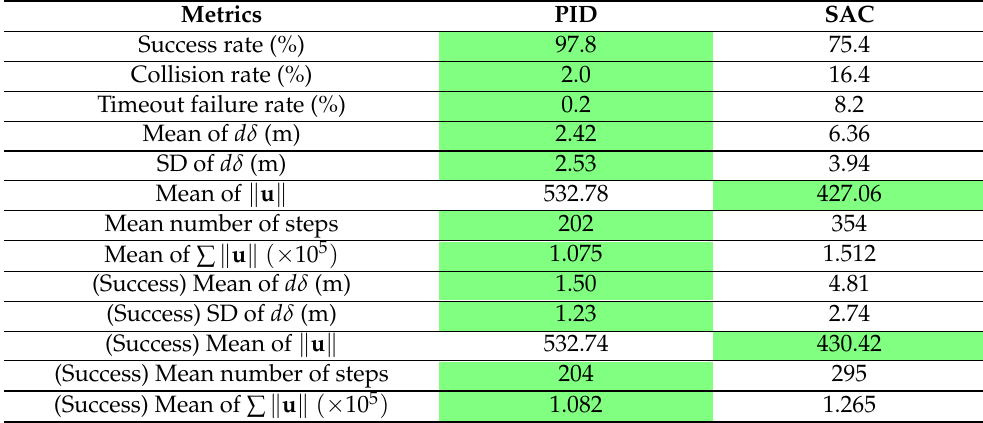
Table 8. The testing phase of a model after removing the linear speeds from the past inputs, trained on 1100 episodes. For each metric, the controller with the best score is highlighted in